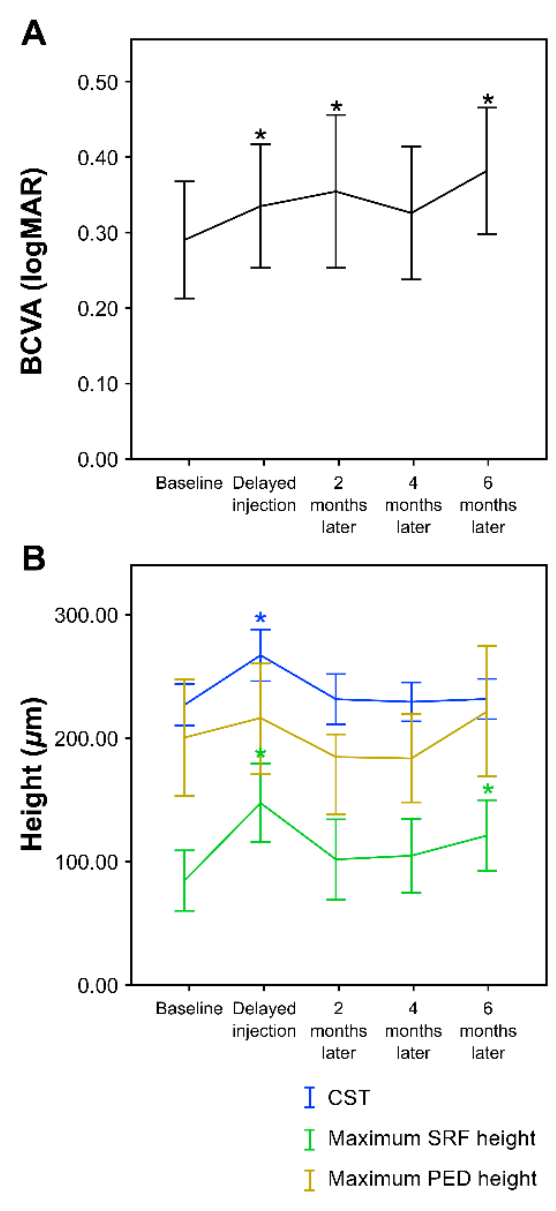
Figure 3. Line graph showing differences in BCVA, CST, maximum SRF height, and maximum PED height between visits. ( A ) Compared to baseline, the BCVA significantly worsened up to 2 months after the time of delayed injection. A trend of temporarily recovering BCVA was observed 4 months after the treatment delay, but it was not statistically significant. In the last follow-up (6 months after the delay), the BCVA was significantly worse than the baseline finding. ( B ) When the OCT findings were quantitatively analyzed, the overall, CST, maximum SRF height, and maximum PED height all deteriorated at the time of delayed injection and then recovered, but eventually showed a pattern of worsening again at approximately 6 months after the treatment delay. At the time of delayed injection, the CST and maximum SRF height showed statistically significant deterioration compared to baseline, and in the final follow-up (6 months), the maximum SRF height was statistically significantly worse than the baseline value. The maximum PED height showed no statistically significant change compared to baseline. Values are presented as means ± 95% confidence interval. BCVA, best-corrected visual acuity; logMAR, logarithm of the minimum angle of resolution; CST, central subfield thickness; SRF, subretinal fluid; PED, pigment epithelial detachment. * Statistically significant compared to baseline.